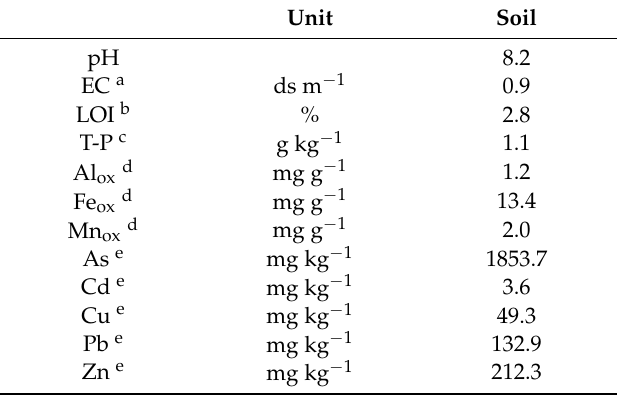
Table 2. Basic properties and trace element concentrations of the soil.